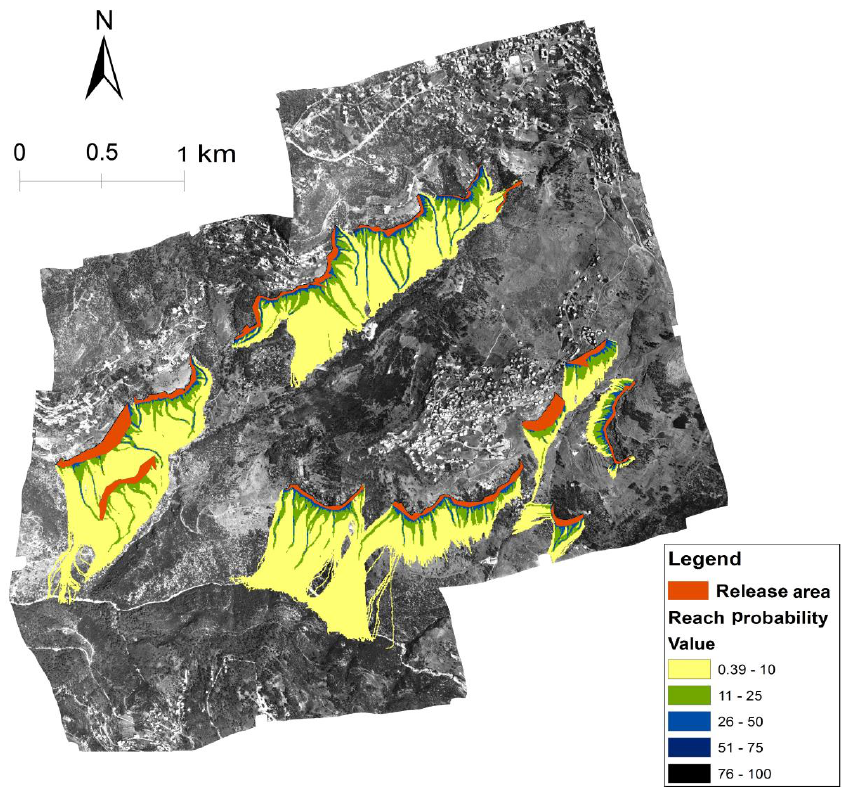
Figure 12. Reach probabilities obtained after 1000 simulations for the worst case scenario: earthquake with magnitude 7.